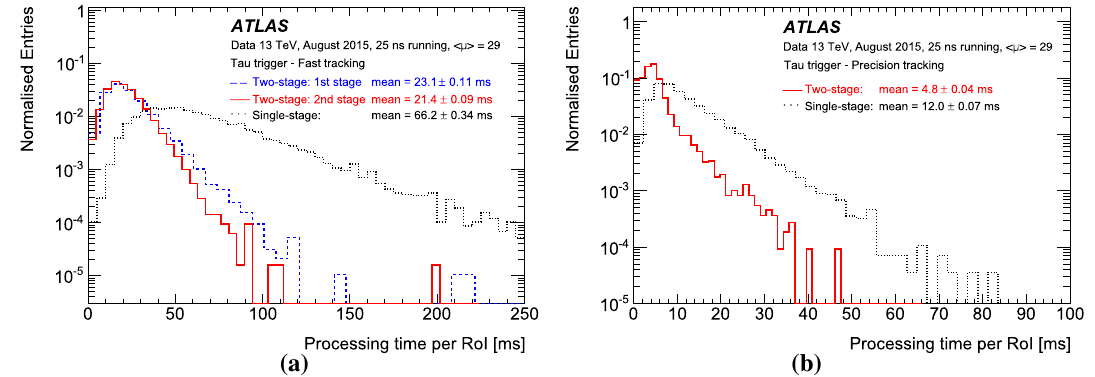
Fig. 12 The ID trigger tau tracking processing time for a the fast track finder and b the precision tracking comparing the single-stage and two-stage tracking